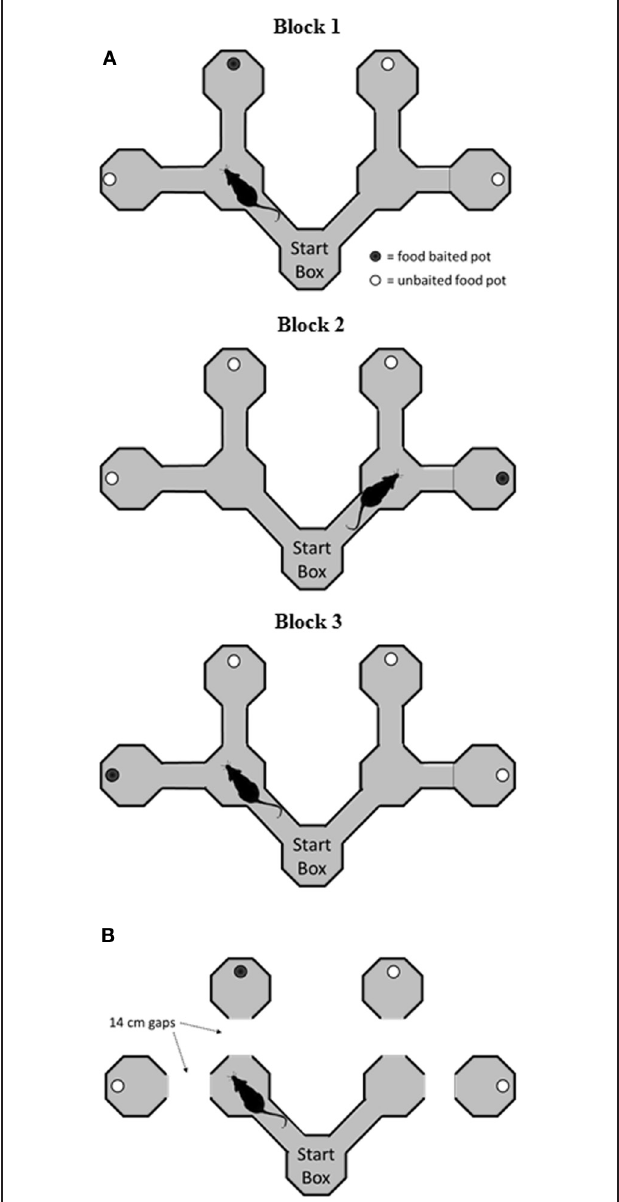
FIGURE 1 | Schematic of the double Y-maze task. (A) Before surgery, rats were trained to find food rewards in a goal box at the end of an arm. On each block of trials, the rewards remained in the same goal box, but across blocks they were shifted to different goal boxes. (B) Following surgery, rats were tested on the same task, but on a modified version of the maze where the rat had to jump across a small gap to reach the goal box. VTEs were recorded in the start box and at the choice points on each